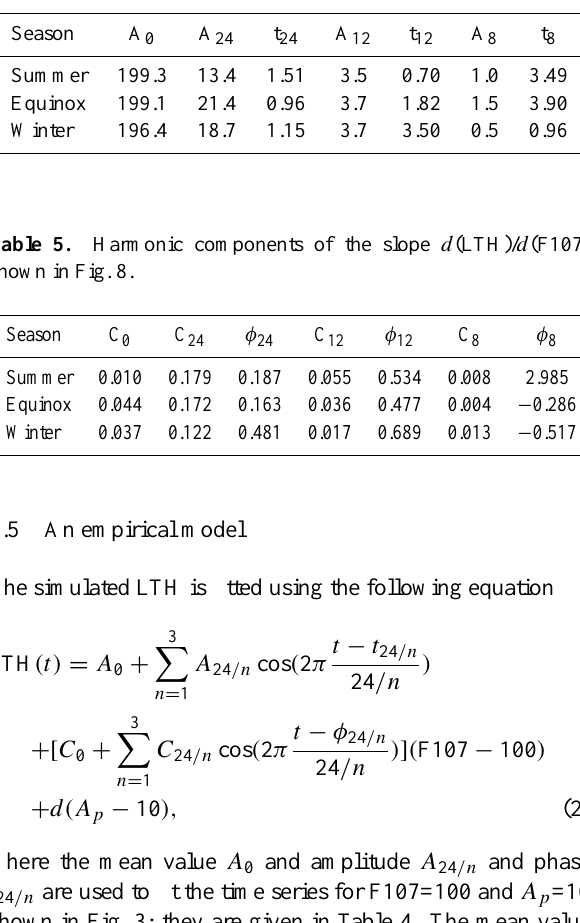
Table 4. Harmonic components of the daily variation of LTH shown in Fig. 3. Amplitudes are in km, and phases in hours.